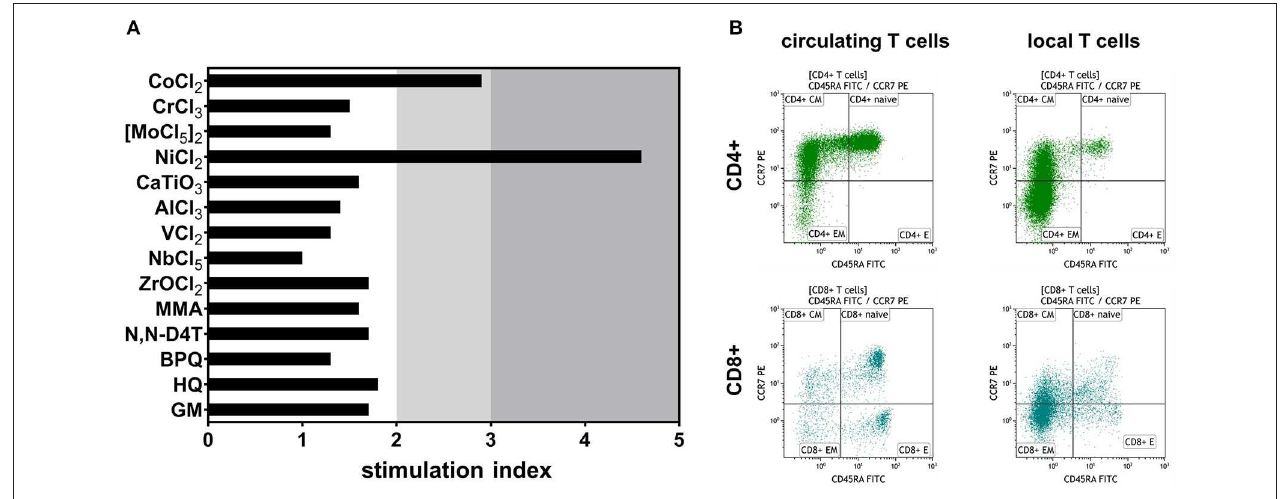
FIGURE 2 | Lymphocyte transformation test (LTT) and T cell subsets analyses point toward T cell mediated hypersensitivity as the root cause for local inflammation. (A) Exposure to various arthroplasty-relevant noxae revealed increased T cell proliferation following cobalt and nickel exposure. Mean stimulation index (proliferation with antigen divided by proliferation without antigen) values ( n = 3) of > 2 indicate marginal sensitization and values > 3 can be considered positive. (B) Scatter dot plots of circulating T helper cells (CD4 + ) and cytotoxic T cells (CD8 + ) indicate abundance of effector memory T cells in the synovium of the affected knee. MMA, methyl methacrylate; N,N-D4T, N,N-dimethyl-p-toluidine; BPQ, benzoyl peroxide; HQ, hydroquinone; GM, gentamicin.